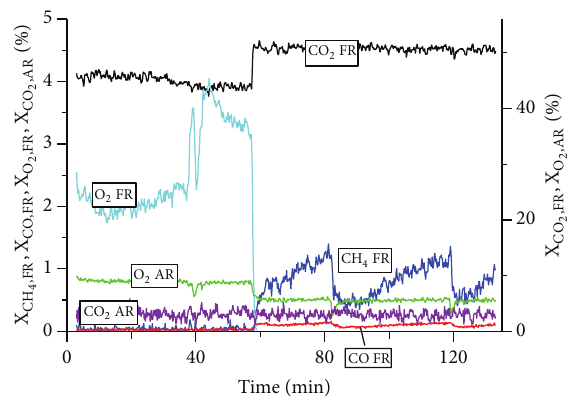
Figure 4: Measured dry gas composition for the transition from CLC II to CLC III . What can be seen is an instance when going is held at 6L N min −1 . The from 0.3 L N min −1 fuel flow to 0.4. 𝐹 AR operation goes from complete fuel conversion with excess oxygen to incomplete fuel conversion.